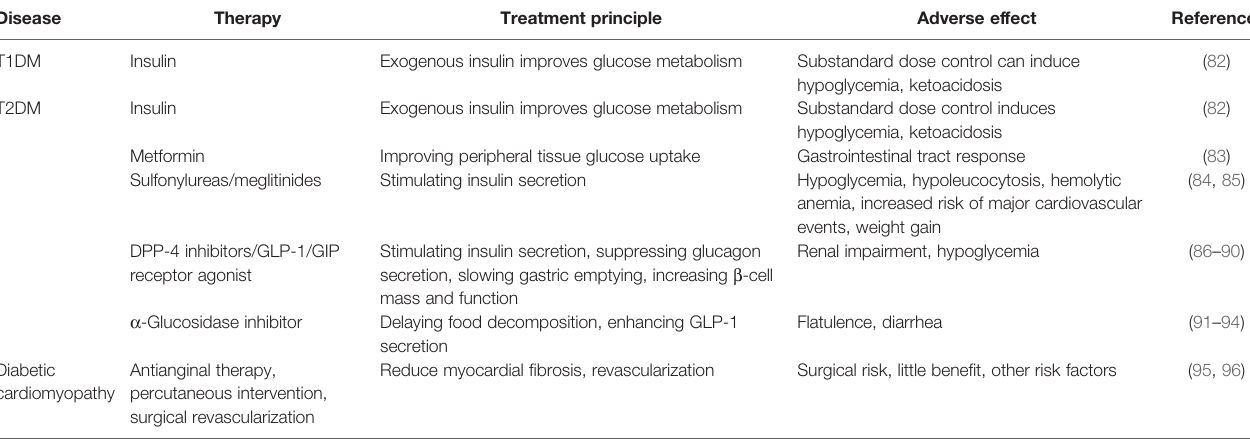
TABLE 3 | The common therapeutic strategies and disadvantages for the DM and its complications. Disease Therapy